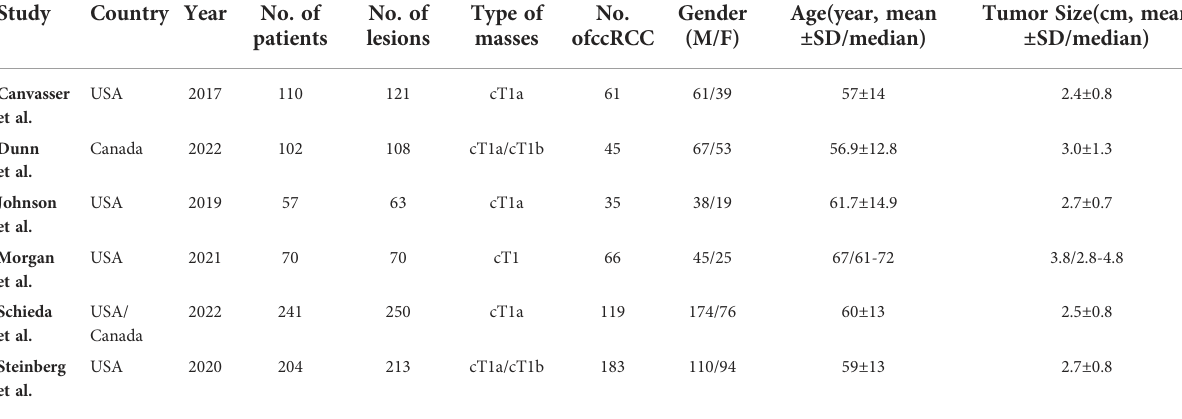
TABLE 1 Demographic Characteristics of Included